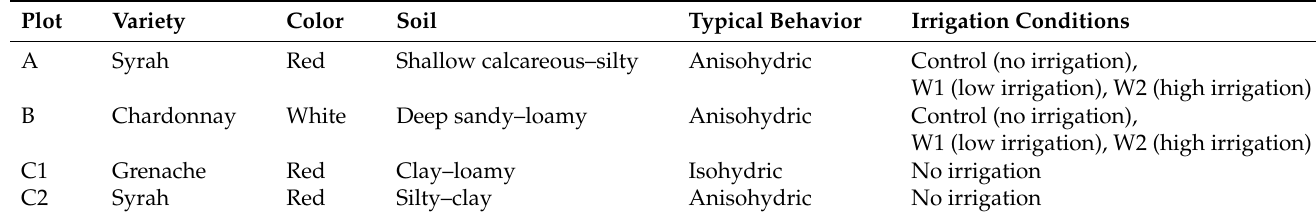
Figure 1. Locations of the four vine plots selected for study in the Occitanie region, France. For each plot, A and B, three different irrigation schemes were monitored in order to have a wide range of SWP values in the same plot at the same time (Table 1). C1 and C2 were chosen as nonirrigated plots and were used for the last two weeks to complete measurements on red varieties in addition to plot A (details are given further). Table 1. Characteristics summary of the four vineyard